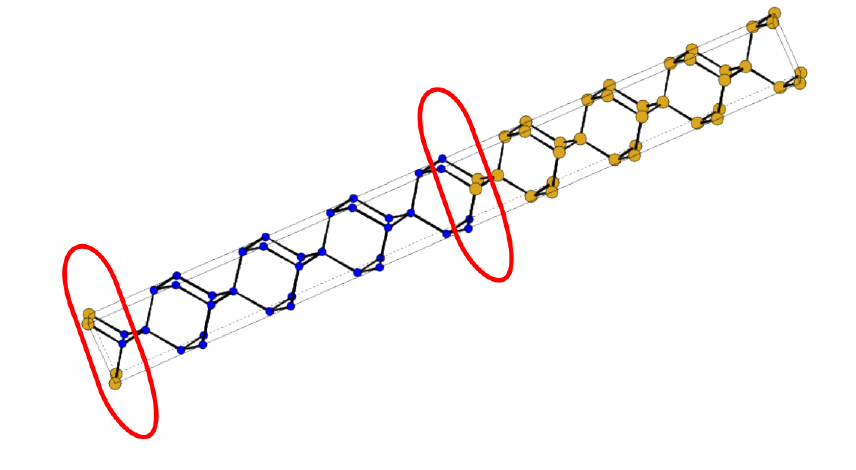
Figure 3. Atomic structure of the Si(D/2)/Ge(D/2)[001] planar superlatiice, with unit cell size D = 4.4 nm containing 8 bilayers of Si and 8 bilayers of Ge. Mass smudging has been considered between only the fist interface atomic layers, i.e., in the regions encircled in